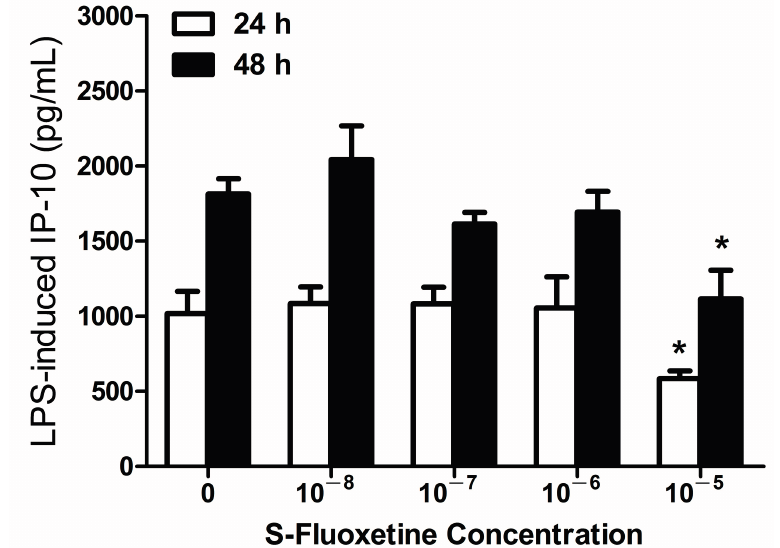
Figure 1. S-fluoxetine (10 − 5 M) suppressed lipopolysaccharide (LPS)-induced Interferon- γ -inducible protein 10 (IP-10) expression in THP-1 cells at 24 and 48 h after LPS (0.2 µg/mL) stimulation. * p < 0.05 compared with the control (LPS-untreated cells).